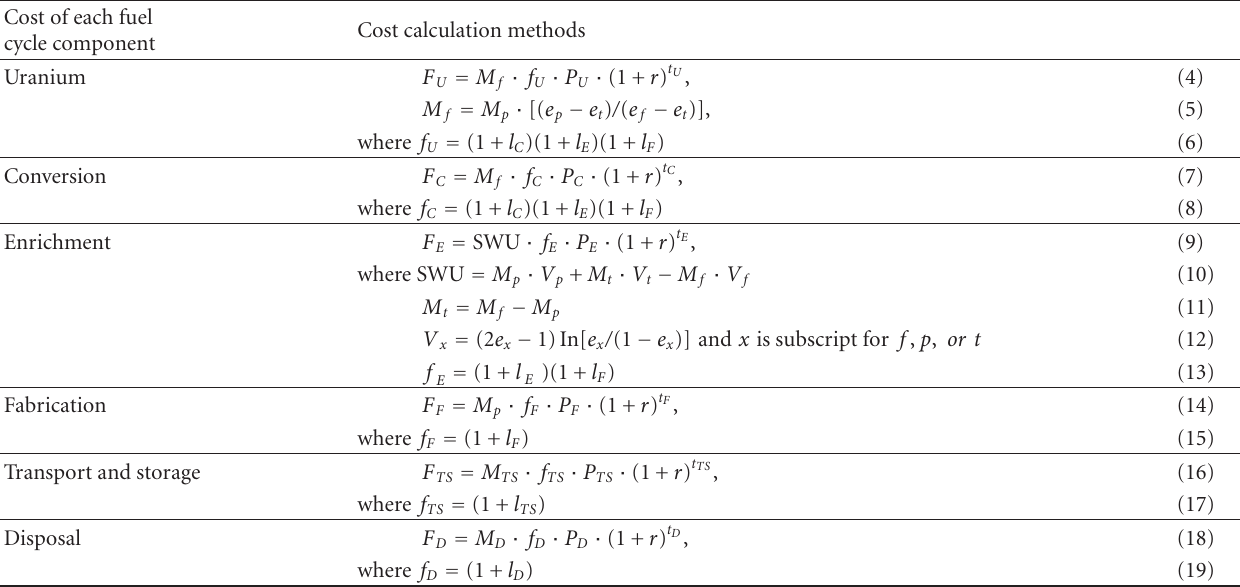
Table 3: Equations used in levelized fuel cycle cost